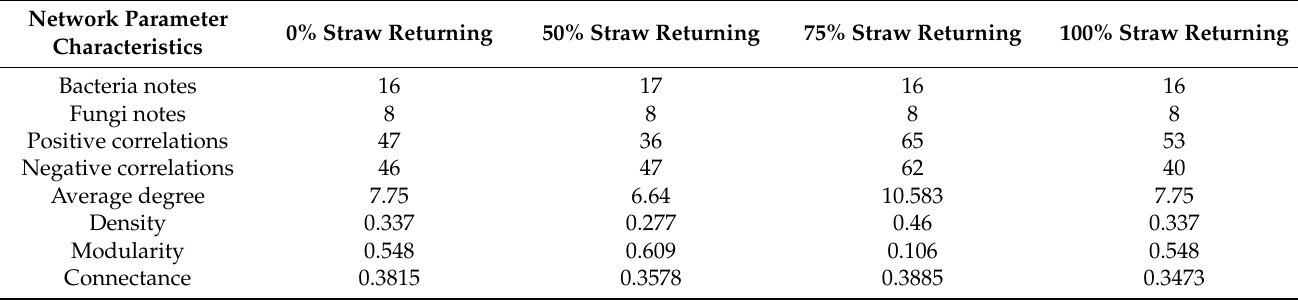
Table A1. Network parameters in the network relationship between bacterial and fungal communities at the phylum level with different amounts of straw added. Each group had three replicates ( n =